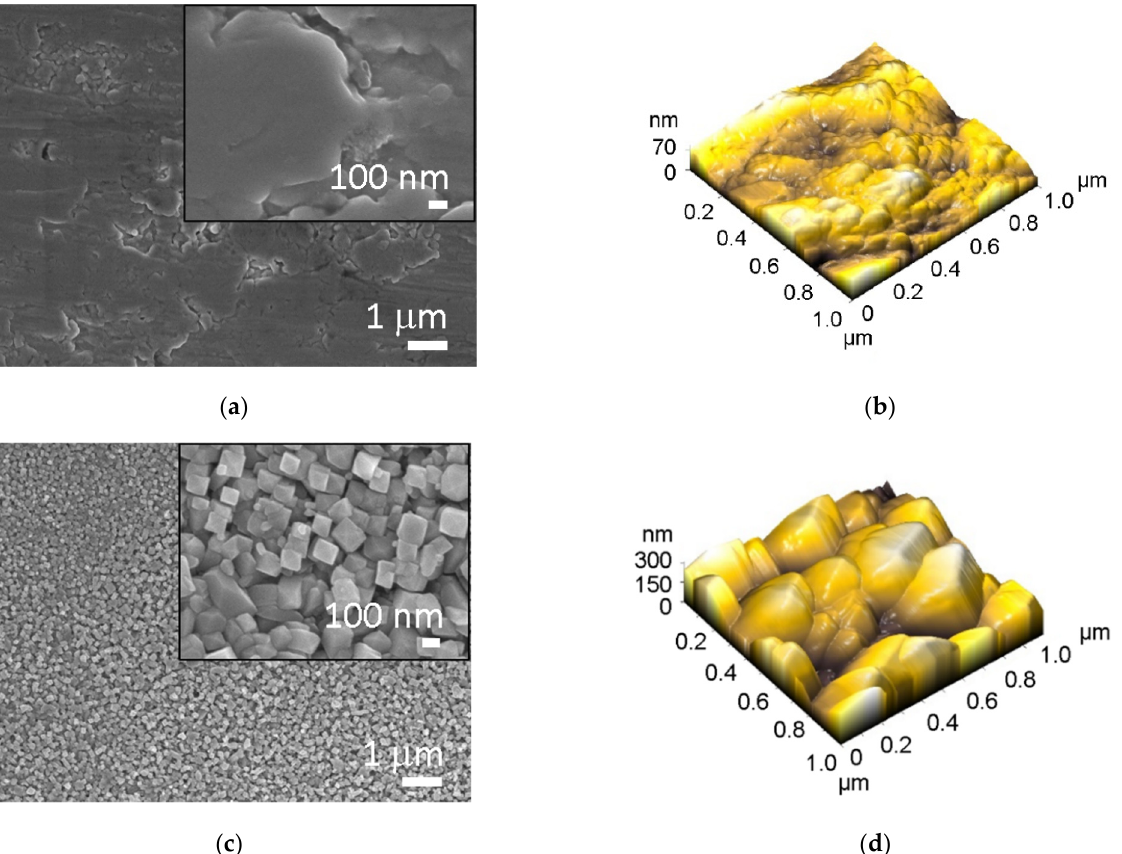
Figure 1. SEM and AFM images of: ( a , b ) untreated Ti foil (Ti), and ( c , d ) hydrothermally treated Ti (Ti HT), respectively.